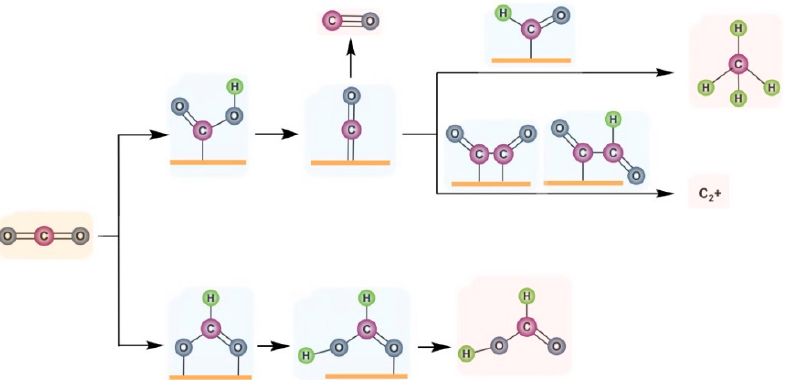
Figure 6. Schematic mechanism for producing different products in CO 2 RR from *COOH and *OCHO intermediates, respectively.